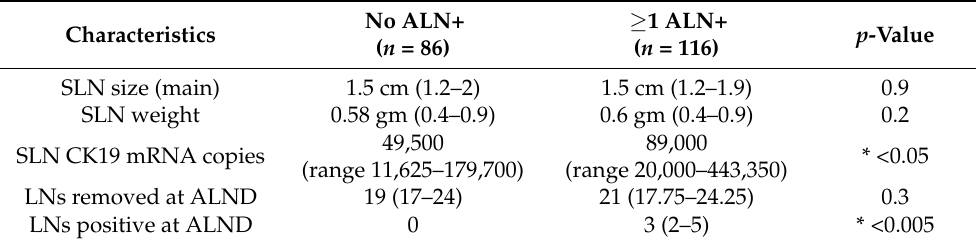
Table 2. Characteristics of SNLs of the 2 groups.